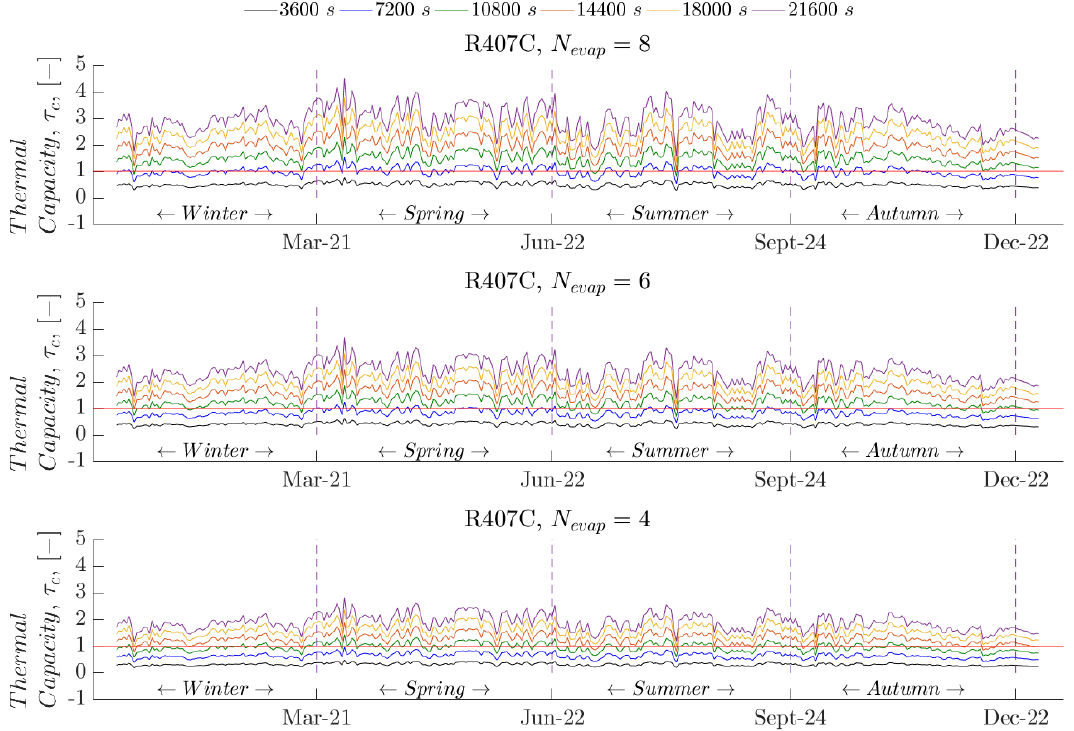
Figure 4. Thermal capacity of the heat pump during the year using R404A as working fluid.